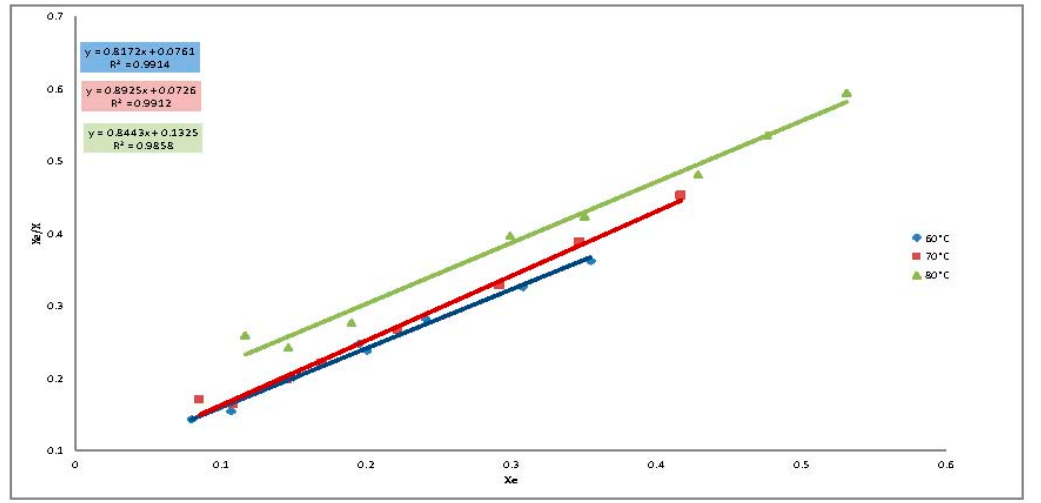
Figure 6. Modeling of the adsorption isotherms decolorization process with ACC using the Langmuir isotherm.